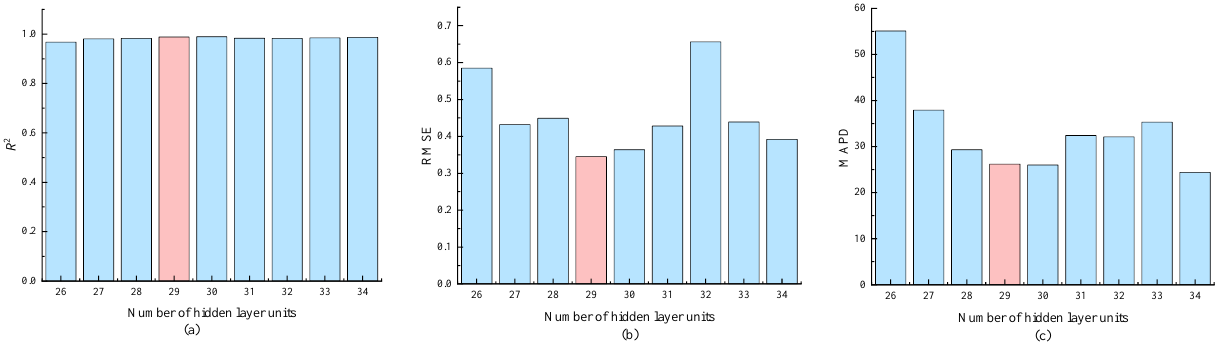
Figure 4. Statistical indicators with the number of hidden-layer units in RBFNN between 26 and 34: ( a ) R 2 ; ( b ) RMSE ; ( c ) MAPD . The red part represents the hidden layer unit eventually adopted, and the blue part represents other units within the range.